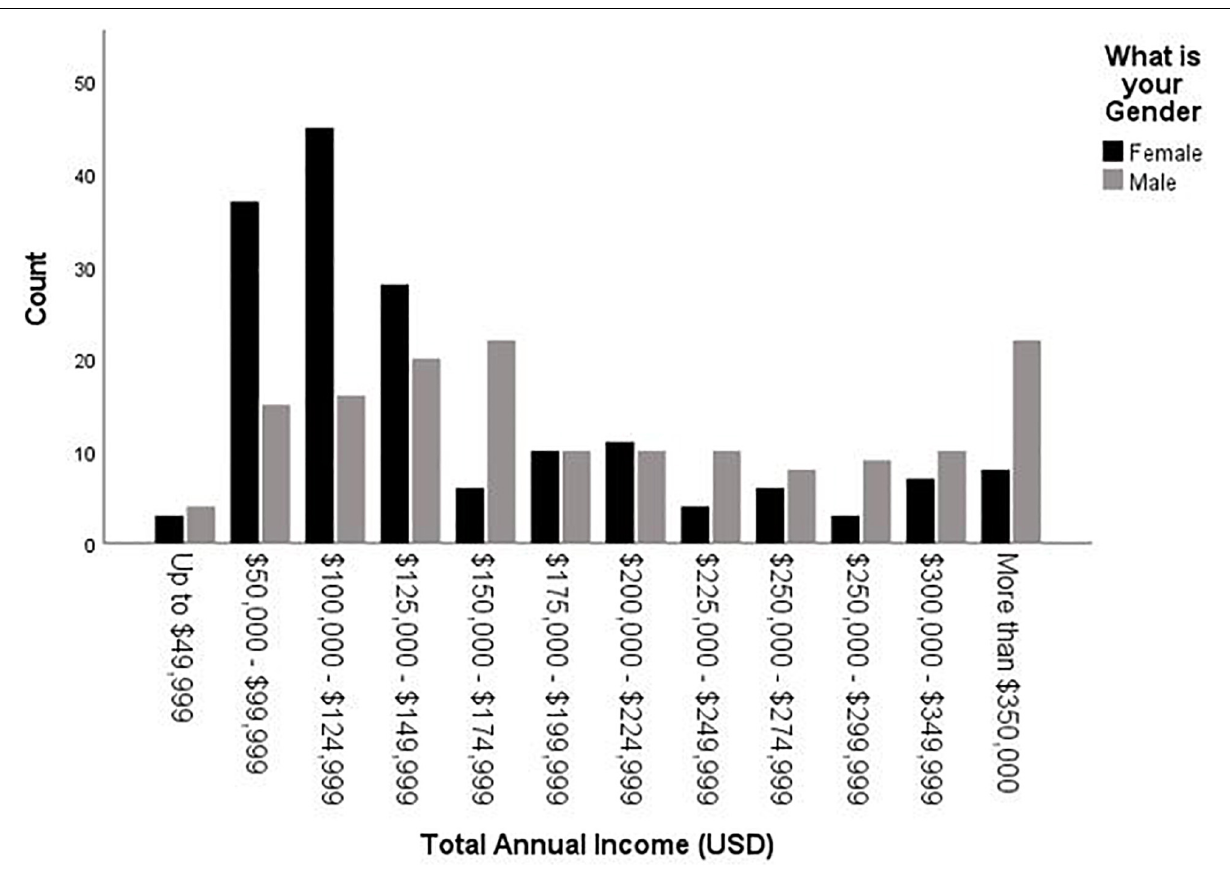
FIGURE 3 | Total annual income (USD) by